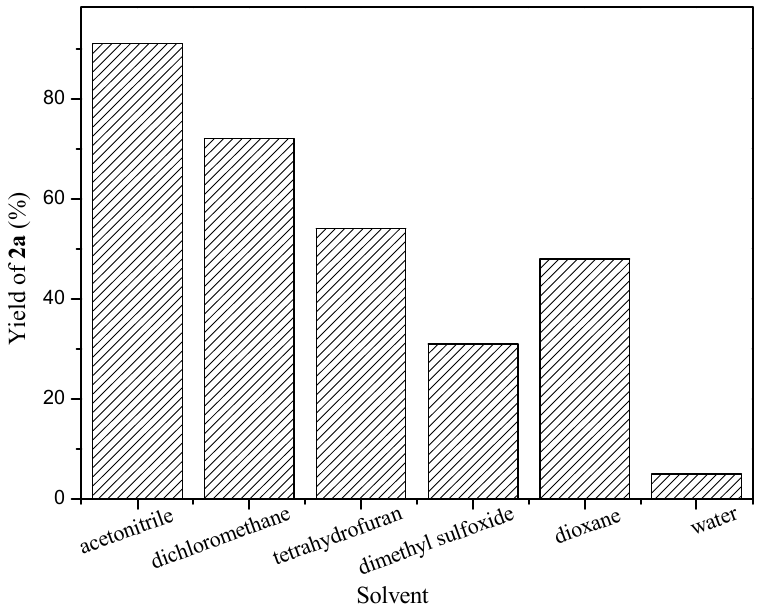
Figure 1. The effect of solvent on the oxidation of salicyl alcohol. Reaction conditions: 1a (1 mmol), solvent (5 mL), UHP (1.1 mmol), n ‐ Caprylic acid (0.2 mmol), TEMPO (0.05 mmol), Novozym 435 (200 U), room temperature, 2 h; isolated yield.